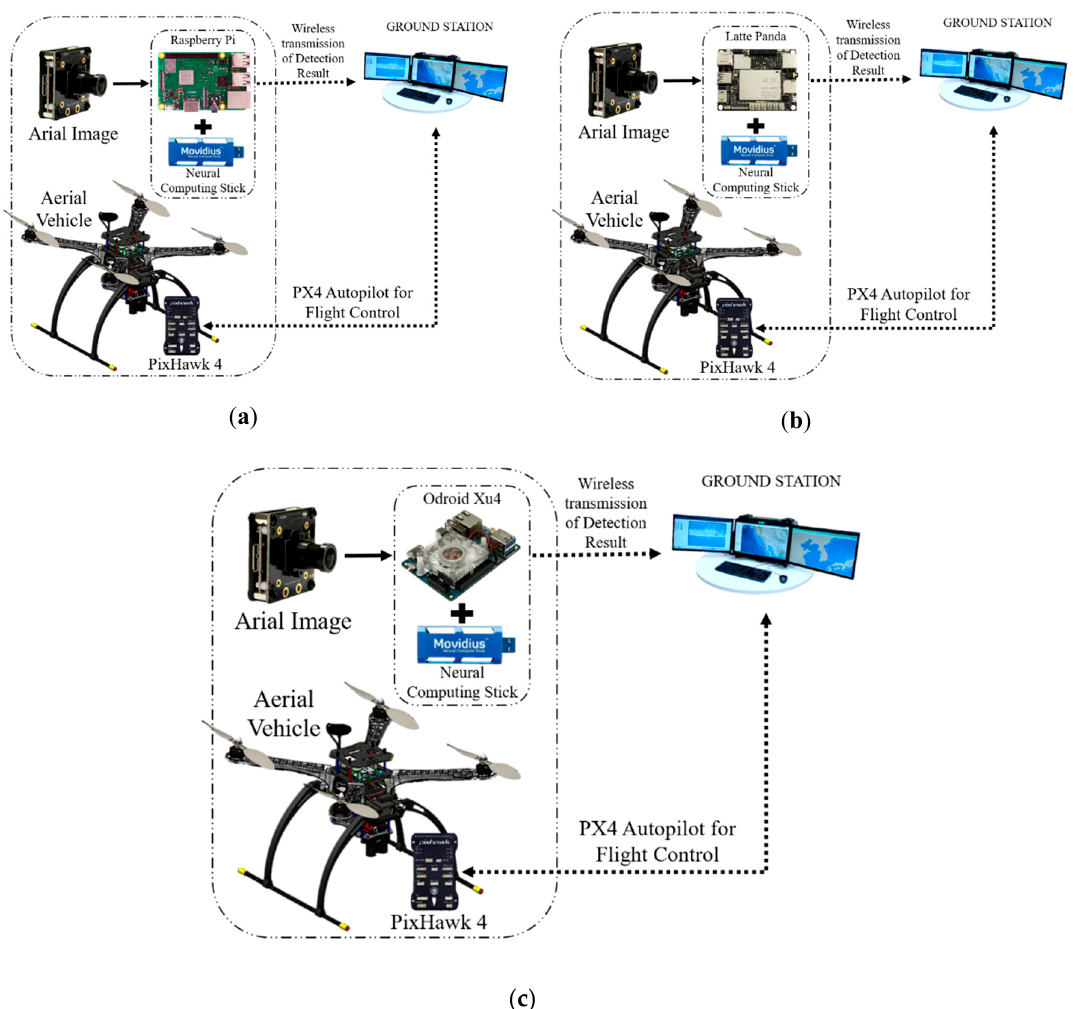
Figure 7. On-board target detection drone system using GPU-constrained devices like ( a ) Raspberry Pi, ( b ) Latte Panda, and ( c ) Odroid Xu4.